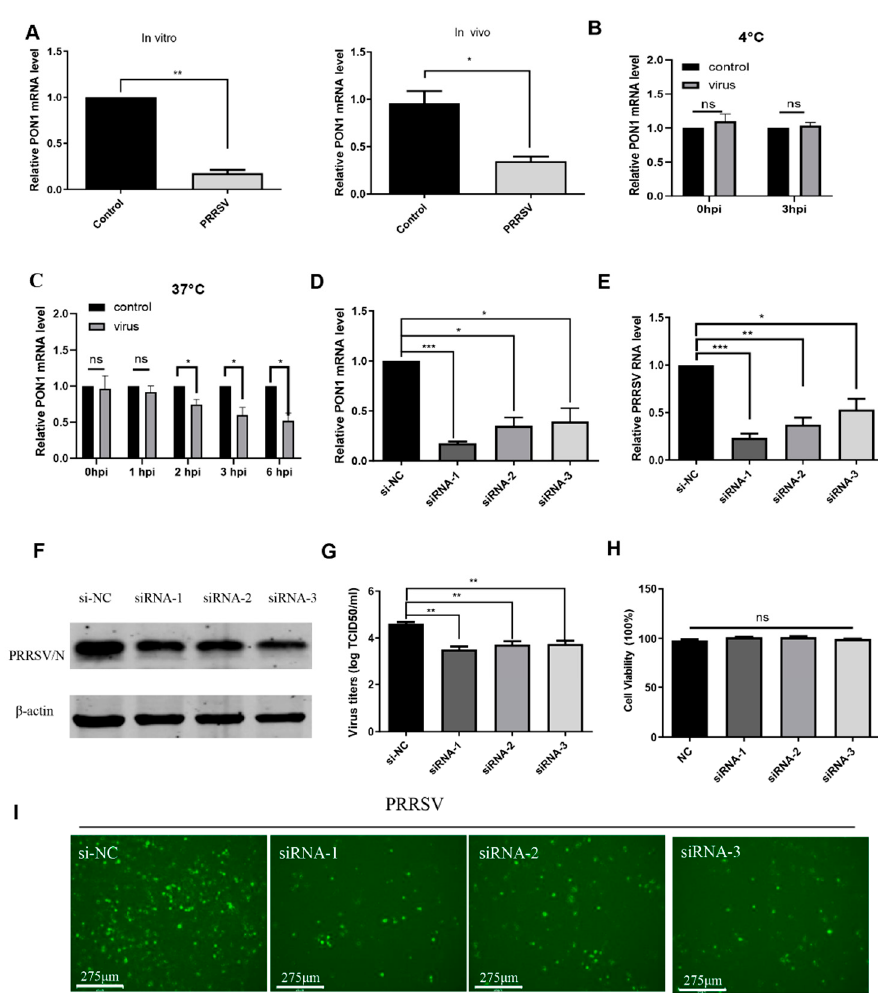
Figure 1. The relationship of PRRSV infection and PON1 expression. ( A ) PON1 is reduced upon PRRSV infection in vitro and in vivo. PAMs and five ‐ week ‐ old SPF pigs were infected with PRRSV strain HuN4. After 24 hpi of PAMs and 3 days post ‐ infection of piglets, the RNA levels of PON1 were determined by qPCR. ( B ) Virus attachment does not affect PON1 expression. The PON1 mRNA level was determined by qPCR after incubating PAMs with the virus at 4 °C. ( C ) Downregulation of PON1 occurs after virus entry. The PON1 mRNA level was determined by qPCR after incubating PAMs with the virus for the indicated time points at 37 °C. ( D ) Three specific siRNAs of PON1 (siRNA ‐ 1, siRNA ‐ 2, and siRNA ‐ 3) and negative control siRNA (si ‐ NC) were transfected into PAMs for 24 h, respectively. The knockdown efficiency of PON1 was determined by qPCR. ( E , F , G ) The depletion of endogenous PON1 inhibits PRRSV replication. After siRNAs were transfected into PAMs for 24 h, the PAMs were infected with PRRSV for 24 h. The effect of PON1 knockdown on PRRSV replication was determined by qPCR ( E ), Western blotting ( F ), and the TCID 50 assay ( G ). ( H ) Transfection of siRNAs has no effect on cell viability. PAMs were transfected with three specific siRNAs of PON1 at the final concentration of 60 nM, respectively. At 24 hpi, a CCK ‐ 8 assay was performed. ( I ) PAMs were transfected with three siRNAs and the negative control for 24 h and then inoculated with the virus. At 24 hpi, the cell monolayers were examined for virus infection by IFA. Data are presented as the mean ± SD. ns (no significant difference), p > 0.05; *, p < 0.05; **, p < 0.01; ***, p < 0.001. The p -value was calculated using a Student’s t -test